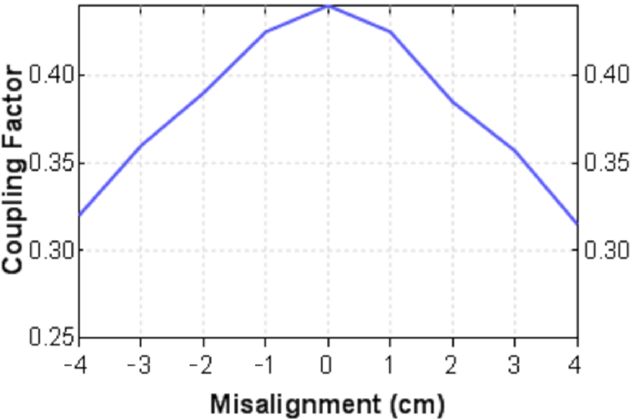
Figure 20. Effect of coil misalignment on coupling coefficient.